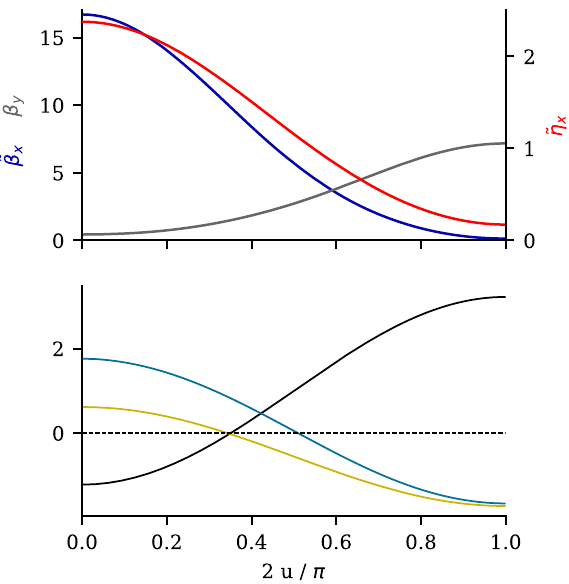
FIG. 6. Top: optical functions for the example solution char- acterized in Table I. Bottom: corresponding distribution of dipole (black), quadrupole (blue), and sextupole fields